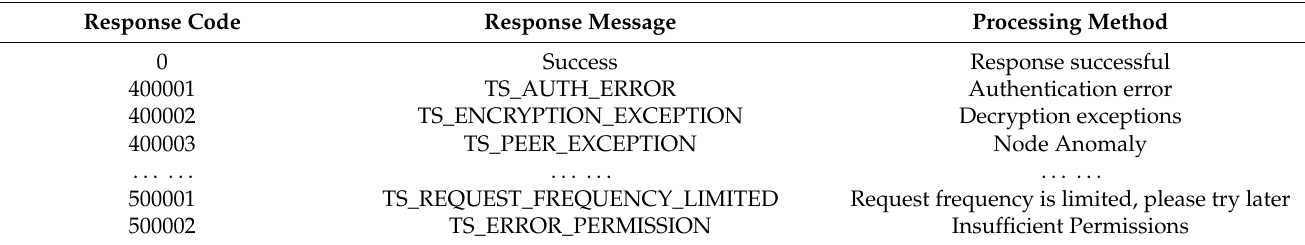
Table 3. API request body